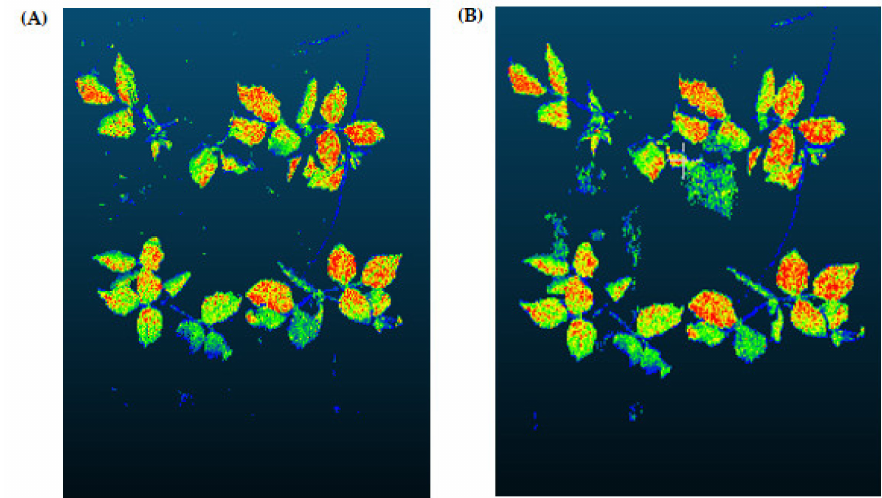
Figure 6. The output of Region Growing Segmentation process for mung bean ( A ). This operation was carried out to increase the accuracy of the proposed pipeline and to minimize false detections.